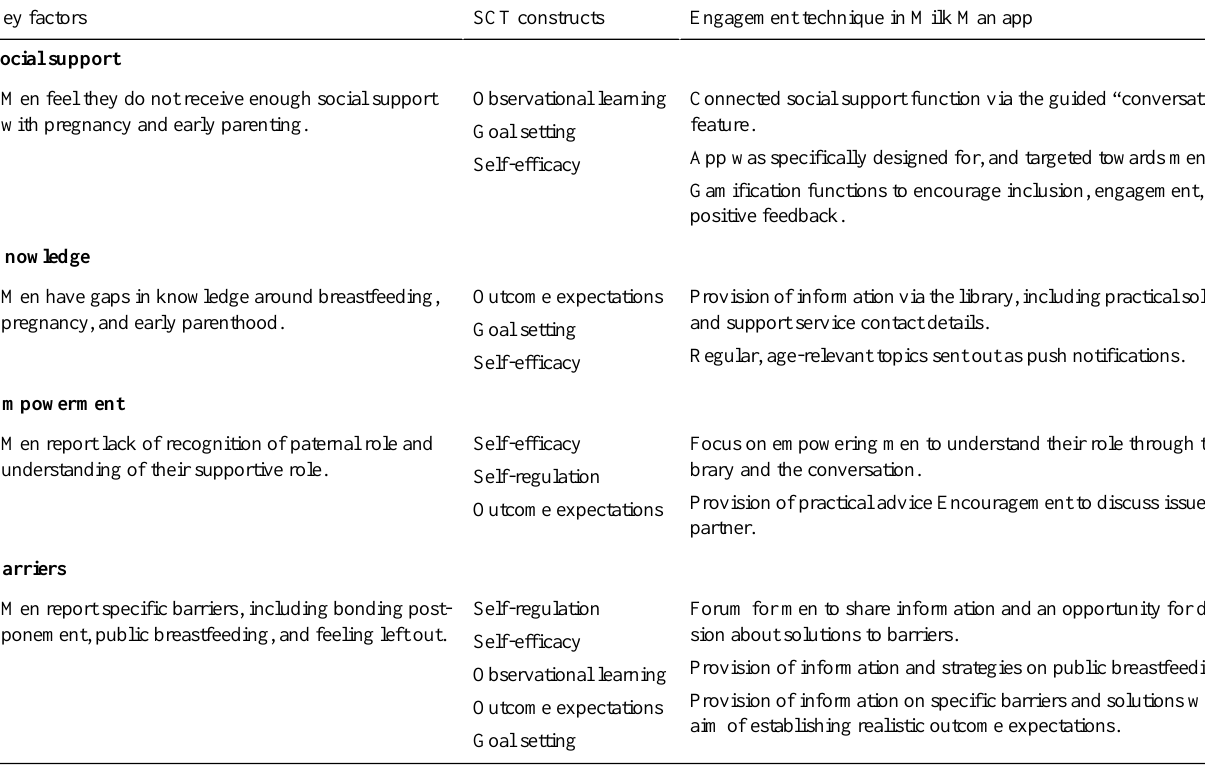
Table 1. Milk Man engagement techniques mapped to social cognitive theory